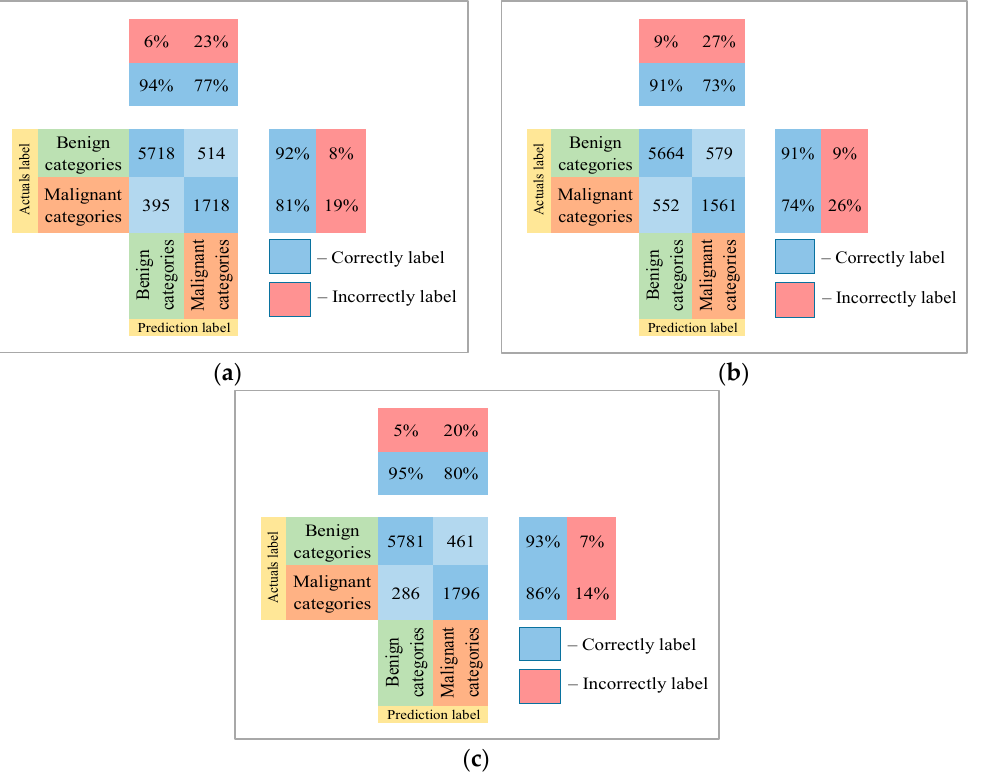
Cancers 2022 , 14 , x FOR PEER REVIEW 18 of 26